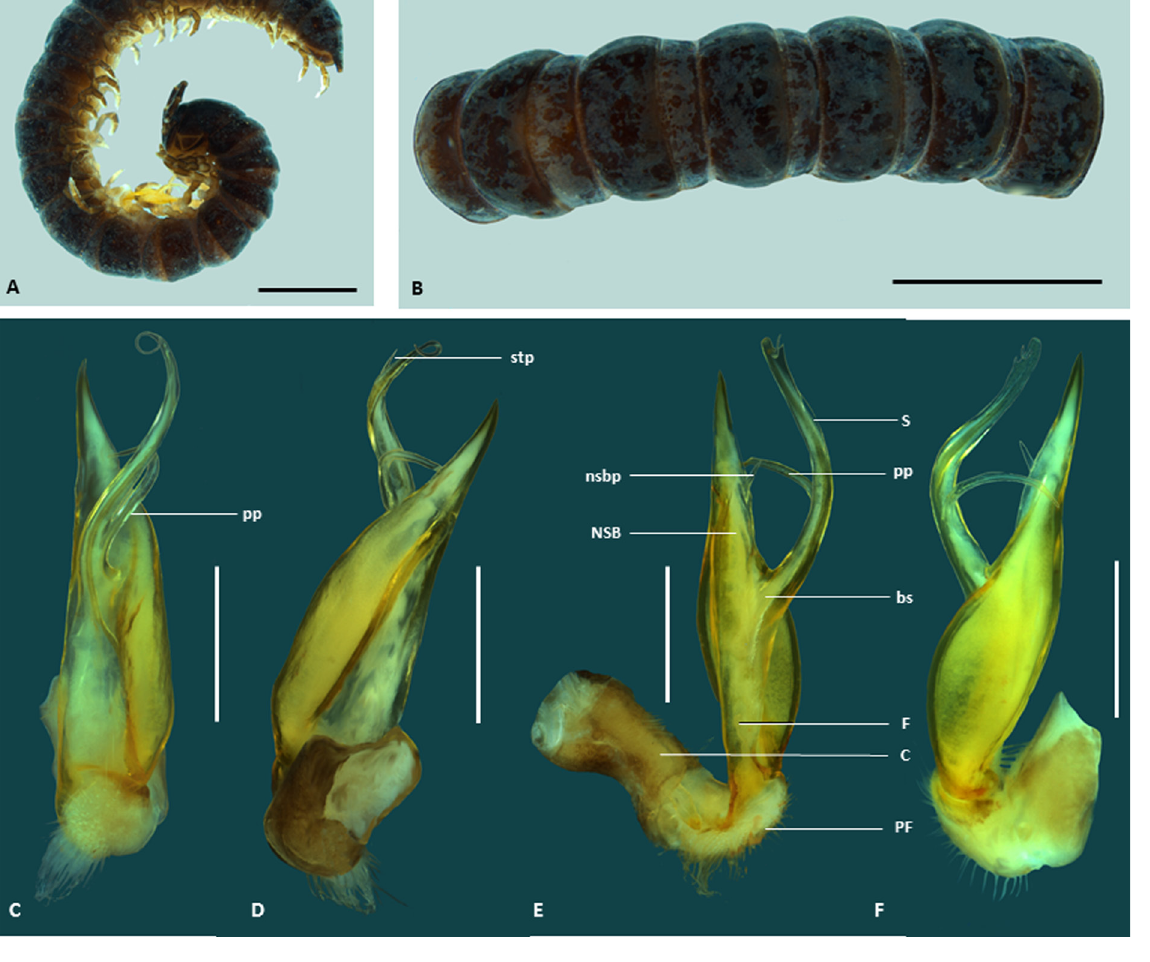
Fig. 3. Boreohesperus psittacinus sp. nov. A . Holotype, ♂, habitus (WAM T132609). B . Paratype, ♂, habitus (WAM T132608). A . Lateral view. B . Dorsal view. C–D , F . holotype, ♂, left gonopod. E . Paratype, ♂, left gonopod. C . Posterior view. D . Anterior view. E . Medial view. F . Lateral view. Abbreviations: bs = solenomere base; C = coxa; F = femorite; NSB = non-seminiferous branch; nsbp = non-seminiferous branch process; PF = prefemur; pp = posterior process; S = solenomere; stp = solenomere tip process. Scale bars: A = 2 mm; B = 1 mm; C–F =